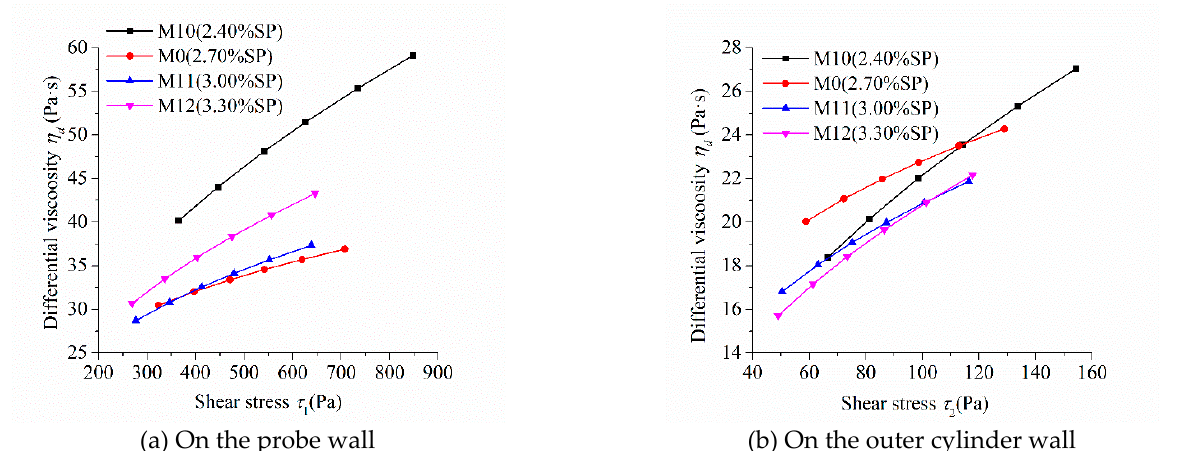
Figure 12. Relationship between the differential viscosity and shear stress of mortars with different dosages of SP.